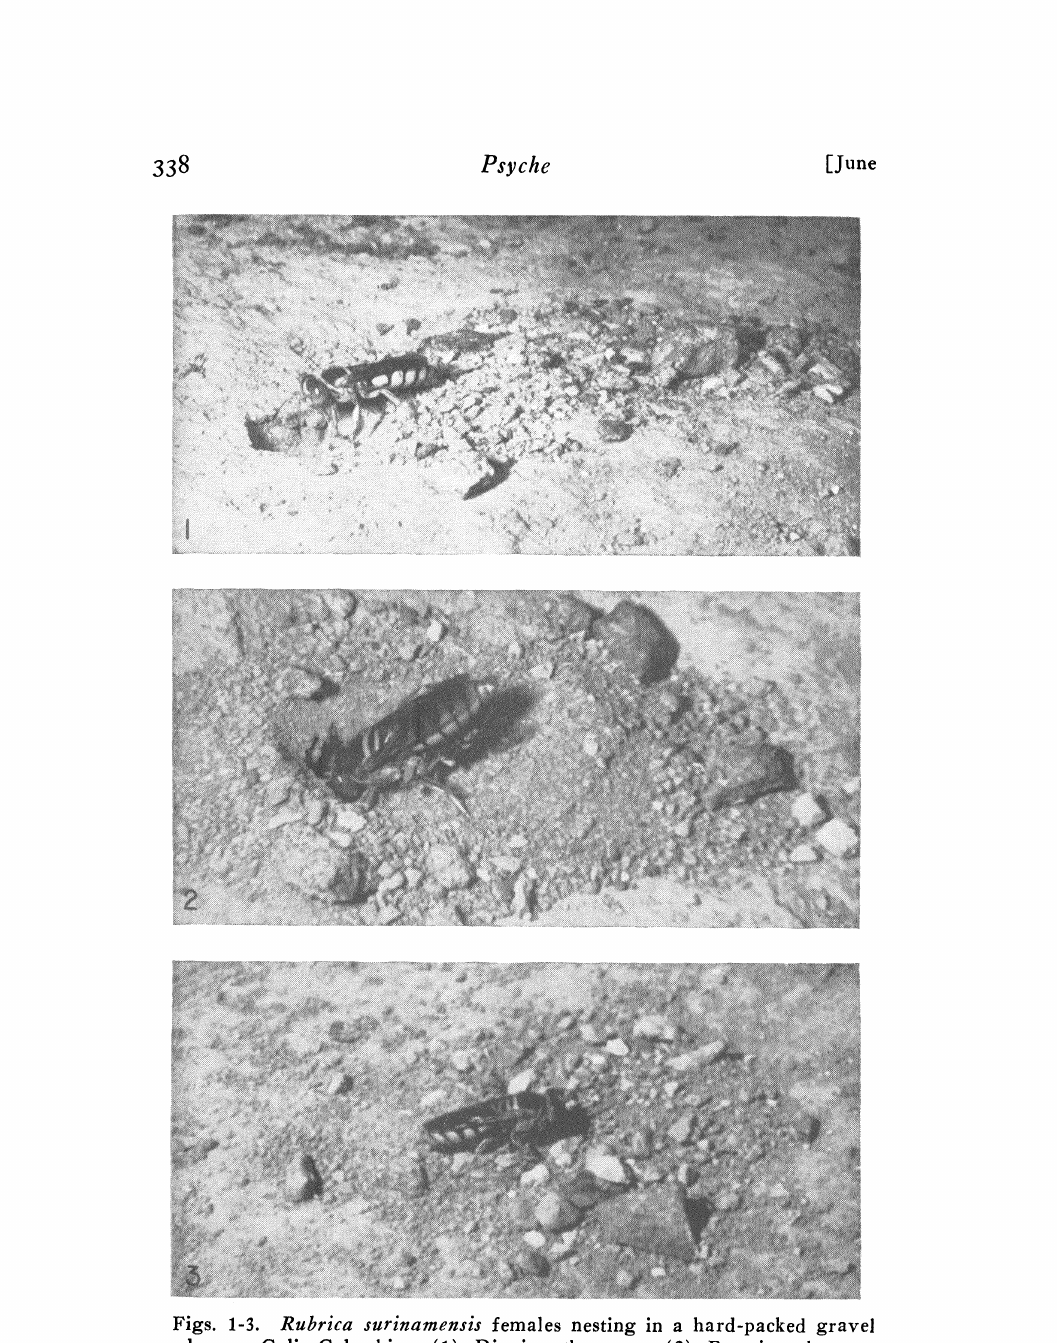
Figs. 1-3. Rubrica surinamensis t:emales nesting in a hard-packed gravel road near Cali, Colombia. (1) Digging the nest. (2) Entering the nest through the entrance pile, carrying a paralyzed fly beneath the abdomen. (3) Restixg on the entrance pile during an inactive